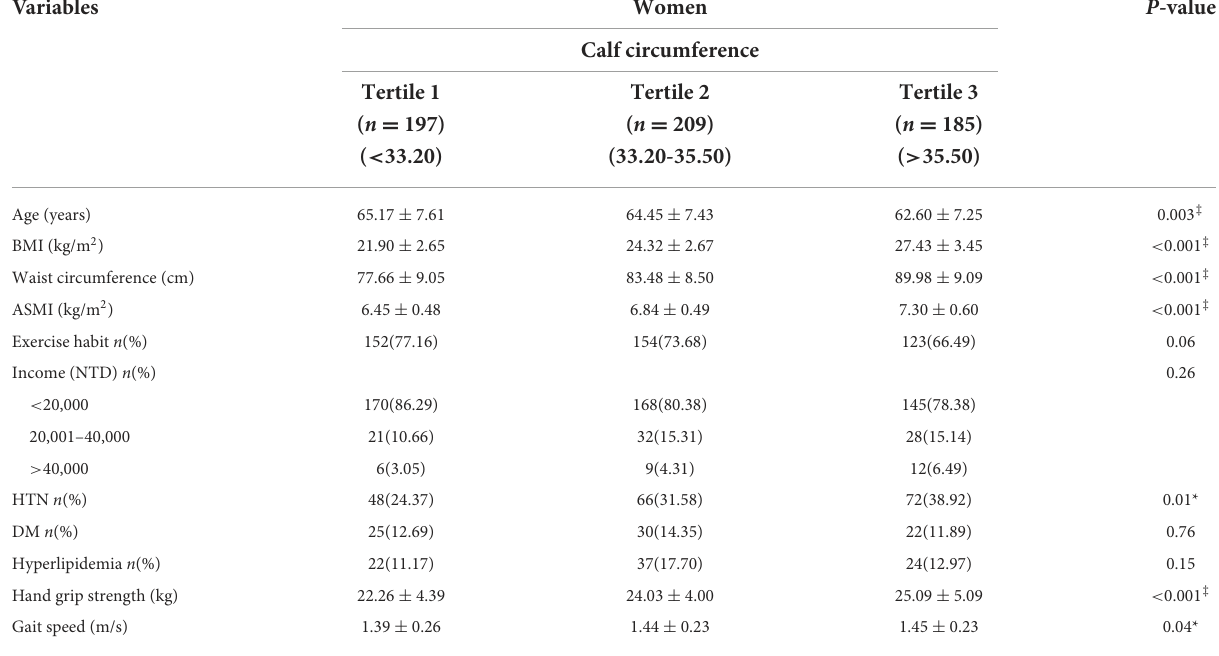
TABLE 2B Baseline characteristics of female participants according to tertile increment of calf